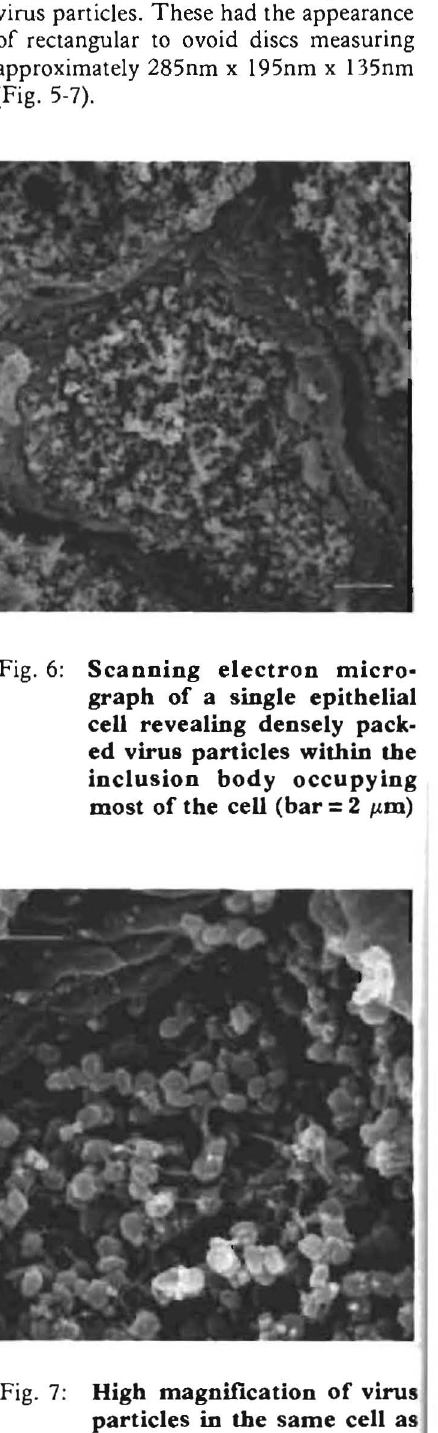
Fig. 7: High magnification of virus particles in the same cell as shown in Fig. 6 (bar = 0,5